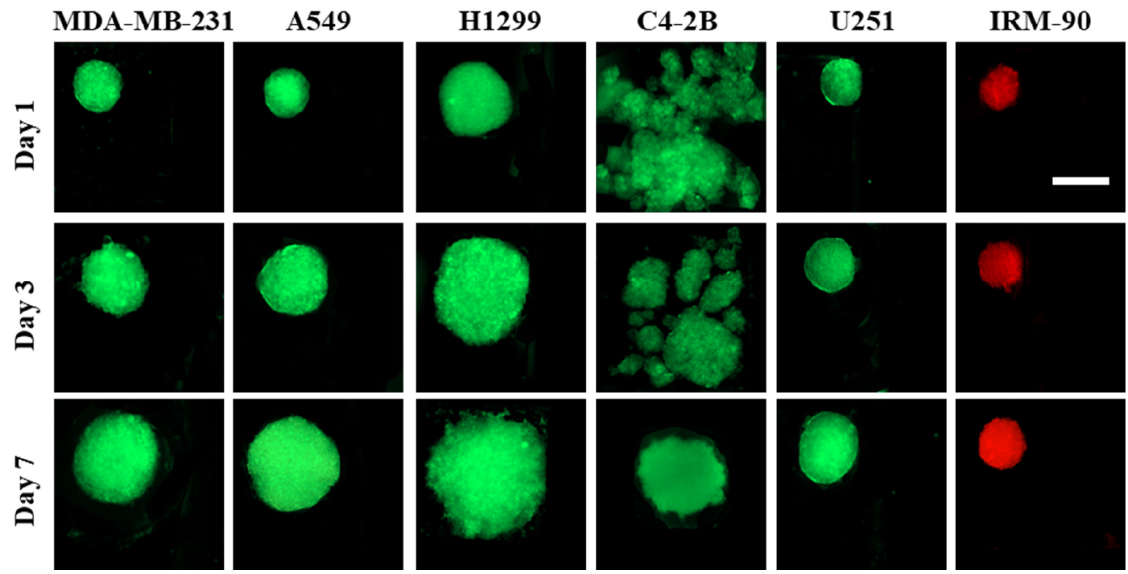
Figure 2. Spheroid formation on PDMS biochips pre-coated with 10% BSA. Fluorescent images of spheroids captured on days 1, 3, and 7 showed that each cell line had its own proliferation rate in the 3D model. All cell lines studied here were able to form spheroids during 7 days of culture. The red color is due to red-fluorescent protein (RFP) in IRM-90 cells and the green color is due to green-fluorescent protein (GFP) in MDA-MB-231 cells. For other cell lines, the green color is due to being fluorescently labeled with cell-labeling solution Vybrant Dio V22886. Scale bars: 200 μm.